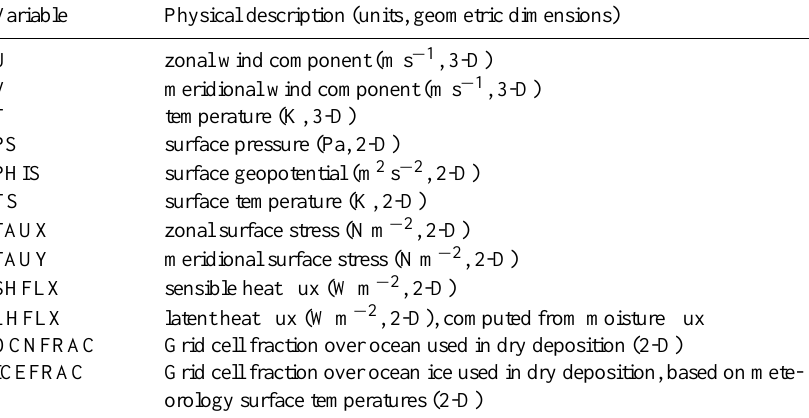
Table 2. List of input fields required for specified dynamics in